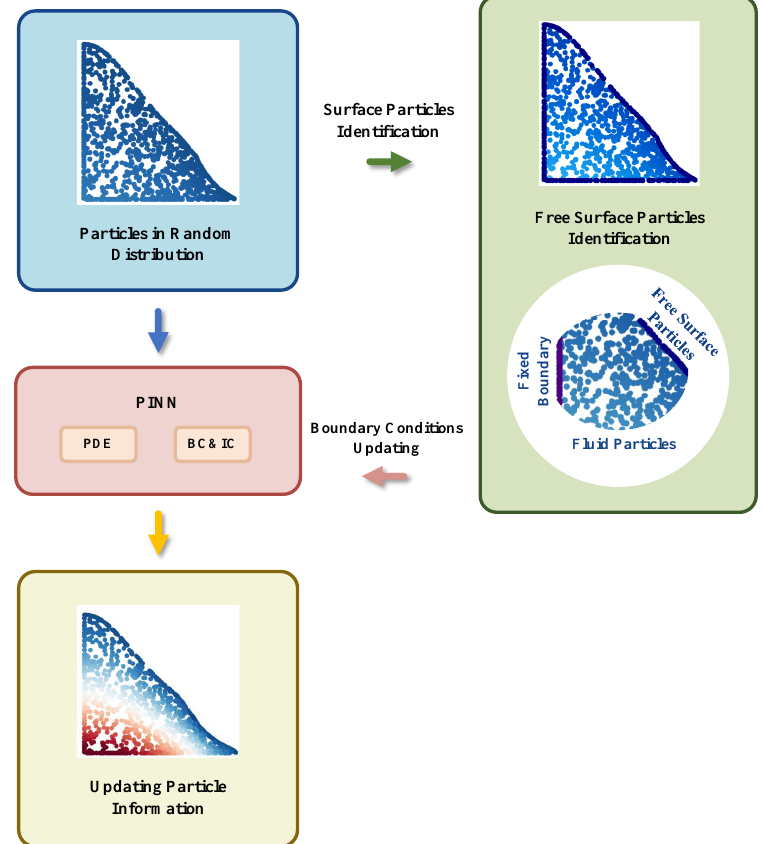
Figure 3. The process of free surface particles identifying and boundary conditions updating in the improved